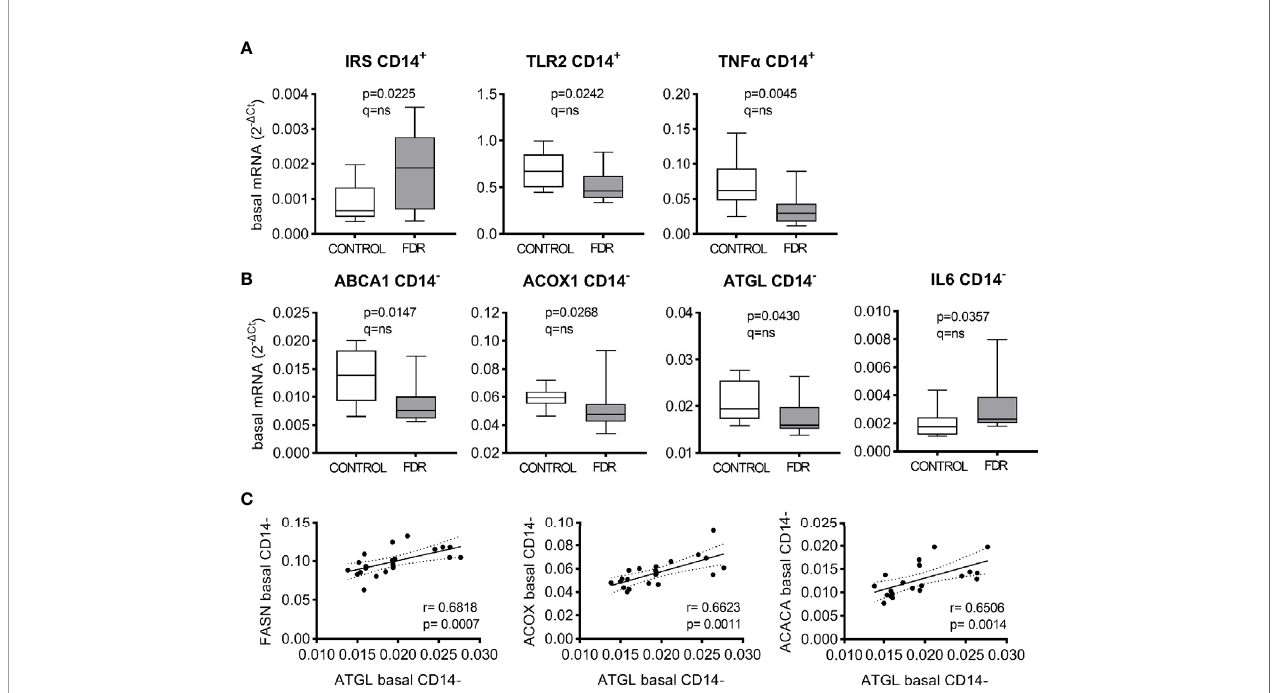
FIGURE 1 | Effect of group (FDR vs. controls) on gene expression in CD14 + (A) and CD14 - (B) peripheral blood mononuclear cells (PBMC) in the fasting (basal) conditions. Gene expression was normalized to the geomean of reference genes RPS13 and TBP and evaluated by Multiple Mann-Whitney tests, with multiple comparisons by False Discovery Rate (method by Benjamini, Krieger, and Yekutieli). Level of signi fi cance for both p and q value was set to <0.05. Box plots show the medians with 25 th and 75 th percentiles, whiskers show min and max values. (C) Correlations of basal gene expressions (2 - D Ct ) of ATGL and other genes involved in lipid handling in CD14 - PBMC. The Spearman rank-order correlation coef fi cient is